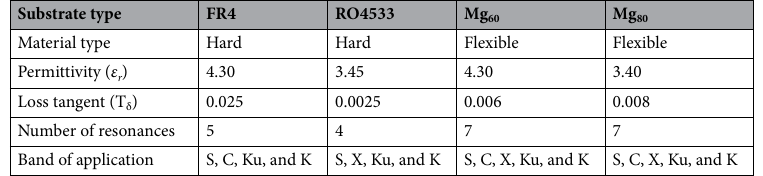
Table 4. Comparison of proposed materials with conventional substrate